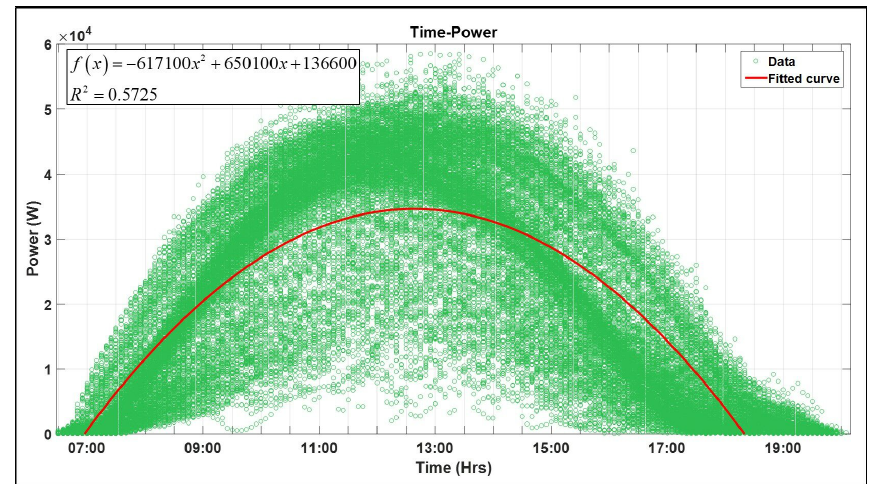
Figure 14. The Power vs. Time of